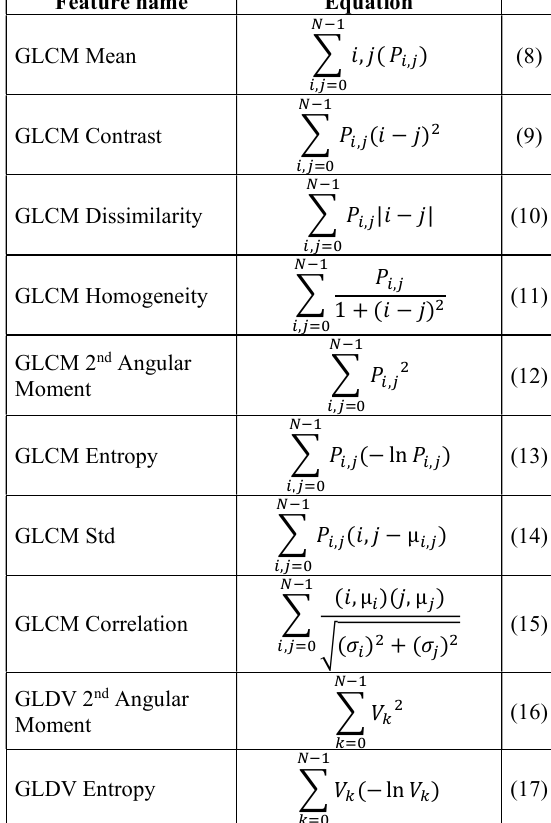
paper and are described on Table 2.